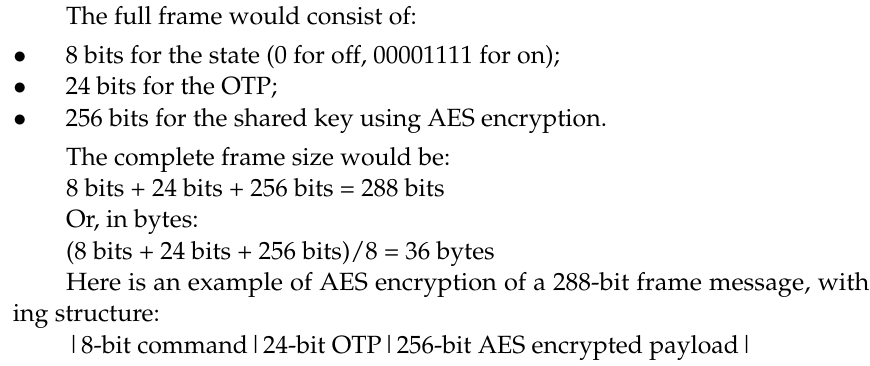
Figure 12. Improving relay control security using AES encryption.